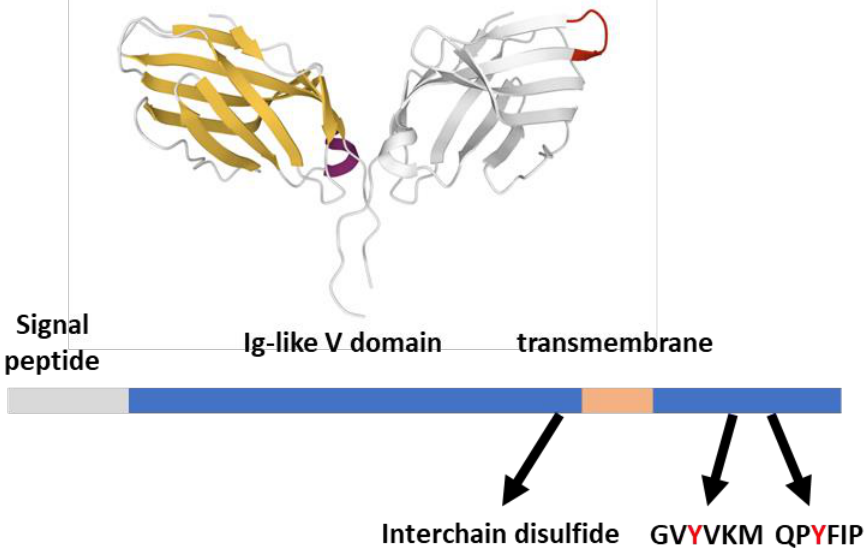
Figure 3. CTLA-4 structural features. CTLA-4 (233 aa) features from the Uniprot database; the Ig-like V domain unbound dimeric structure (one subunit in gray with MYPPPY ligand binding evidenced in red) is 3OSK [12], rendered by the Mol* application [10].